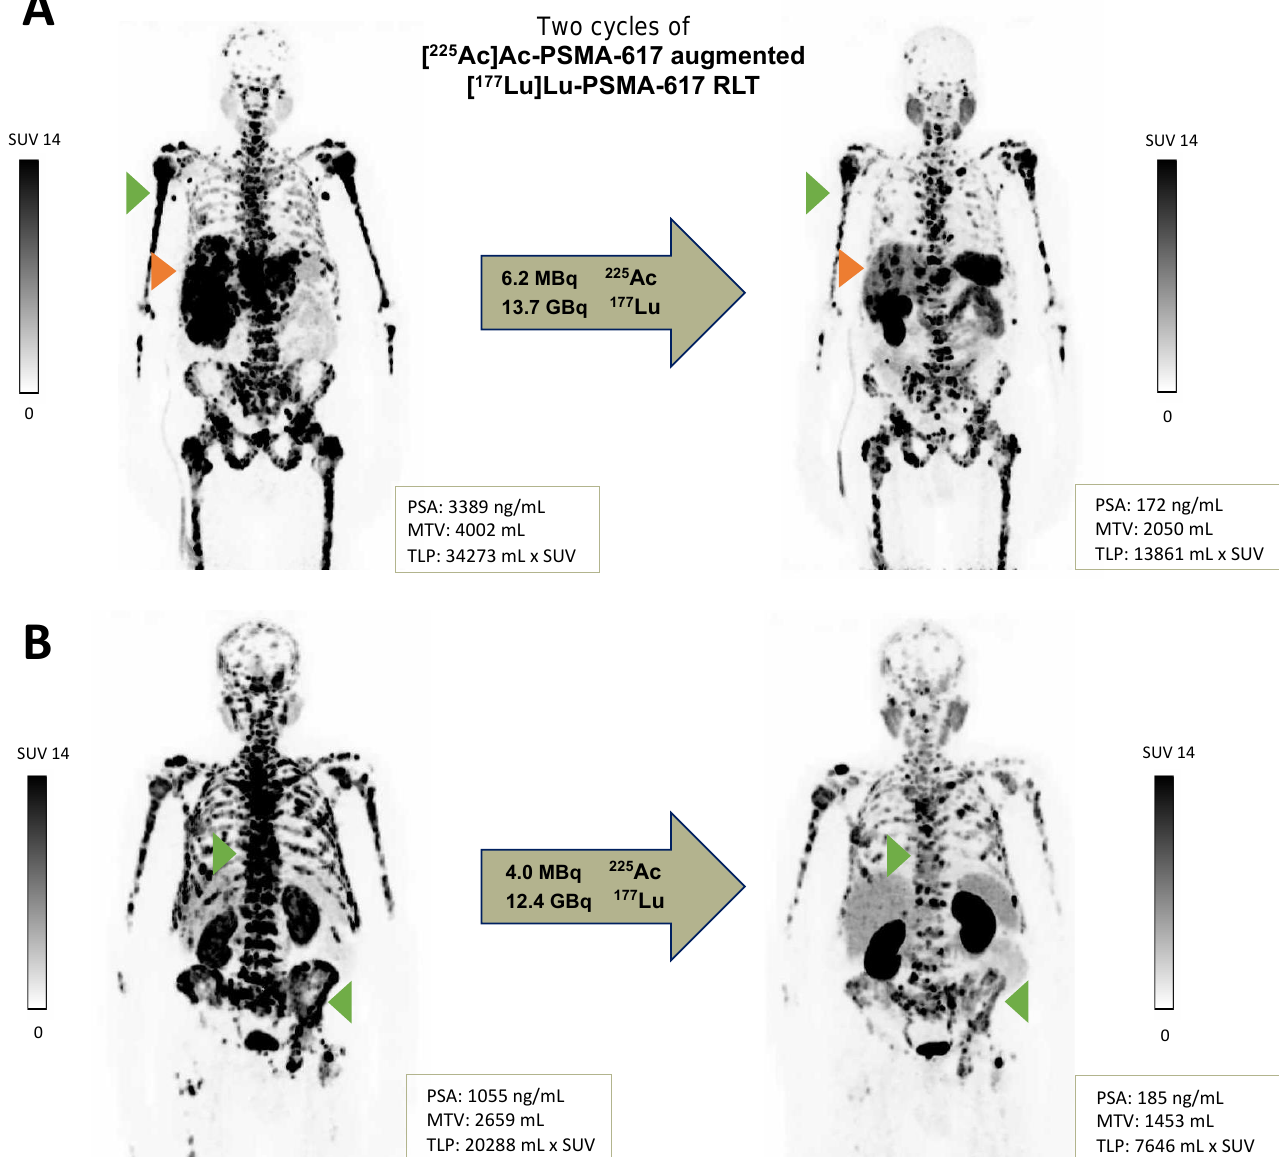
Figure 2. [ 68 Ga]Ga-PSMA-11 PET/CT images of two mCRPC patients ( A , B ) at baseline and after two cycles of [ 225 Ac]Ac- PSMA-617 augmented [ 177 Lu]Lu-PSMA-617 RLT showing partial remission (exemplary: liver metastases, orange arrow; bone metastases, green arrow).